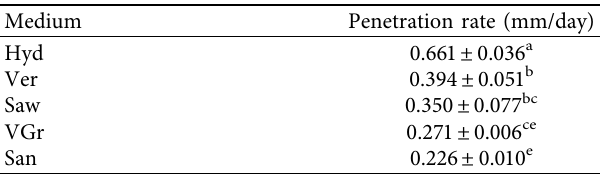
Table 4: Root penetration rate of cedar seedlings on different media.